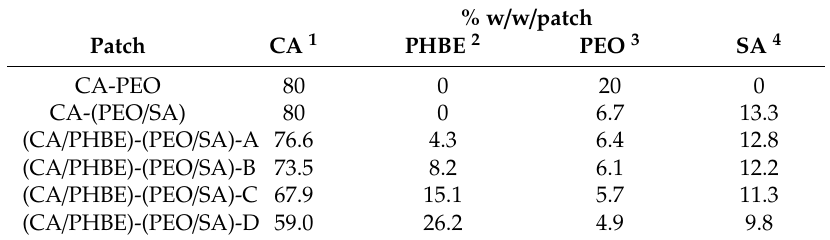
Table 1. Electrospun micro / nanofibrous mats composed of di ff erent weight ratios of pine bark extract. % w / w /